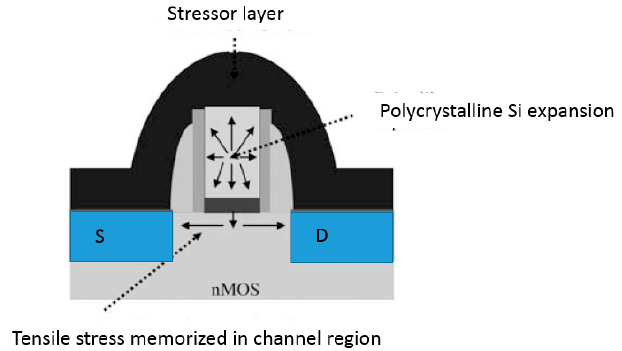
Figure 3. Schematic of stress memorization technique (SMT) in n-type metal oxide semiconductor (nMOS) with a stressor cap layer.